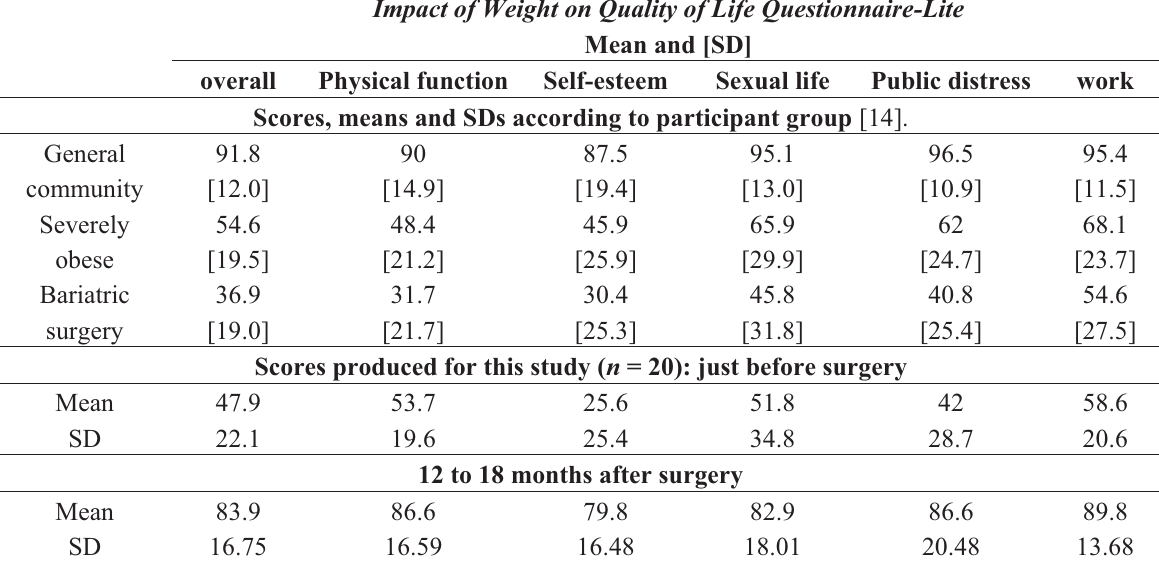
Table 3. Results of the IWQOL-Lite